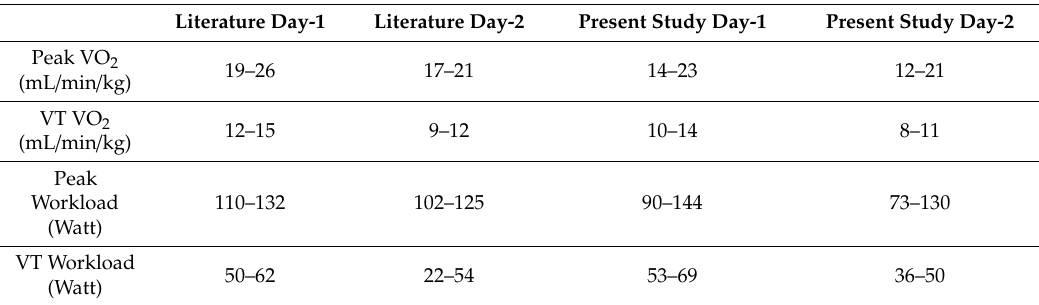
Table 5. Ranges of CPET parameters (oxygen consumption at peak exercise and at the ventilatory threshold, workload at peak exercise and at the ventilatory threshold) in previous literature ranging from the minimal to the maximal value reported on day-1 and day-2 and the ranges from the CPET values from the present study ranging from the minimum value (severe disease) to the maximal value (mild disease)